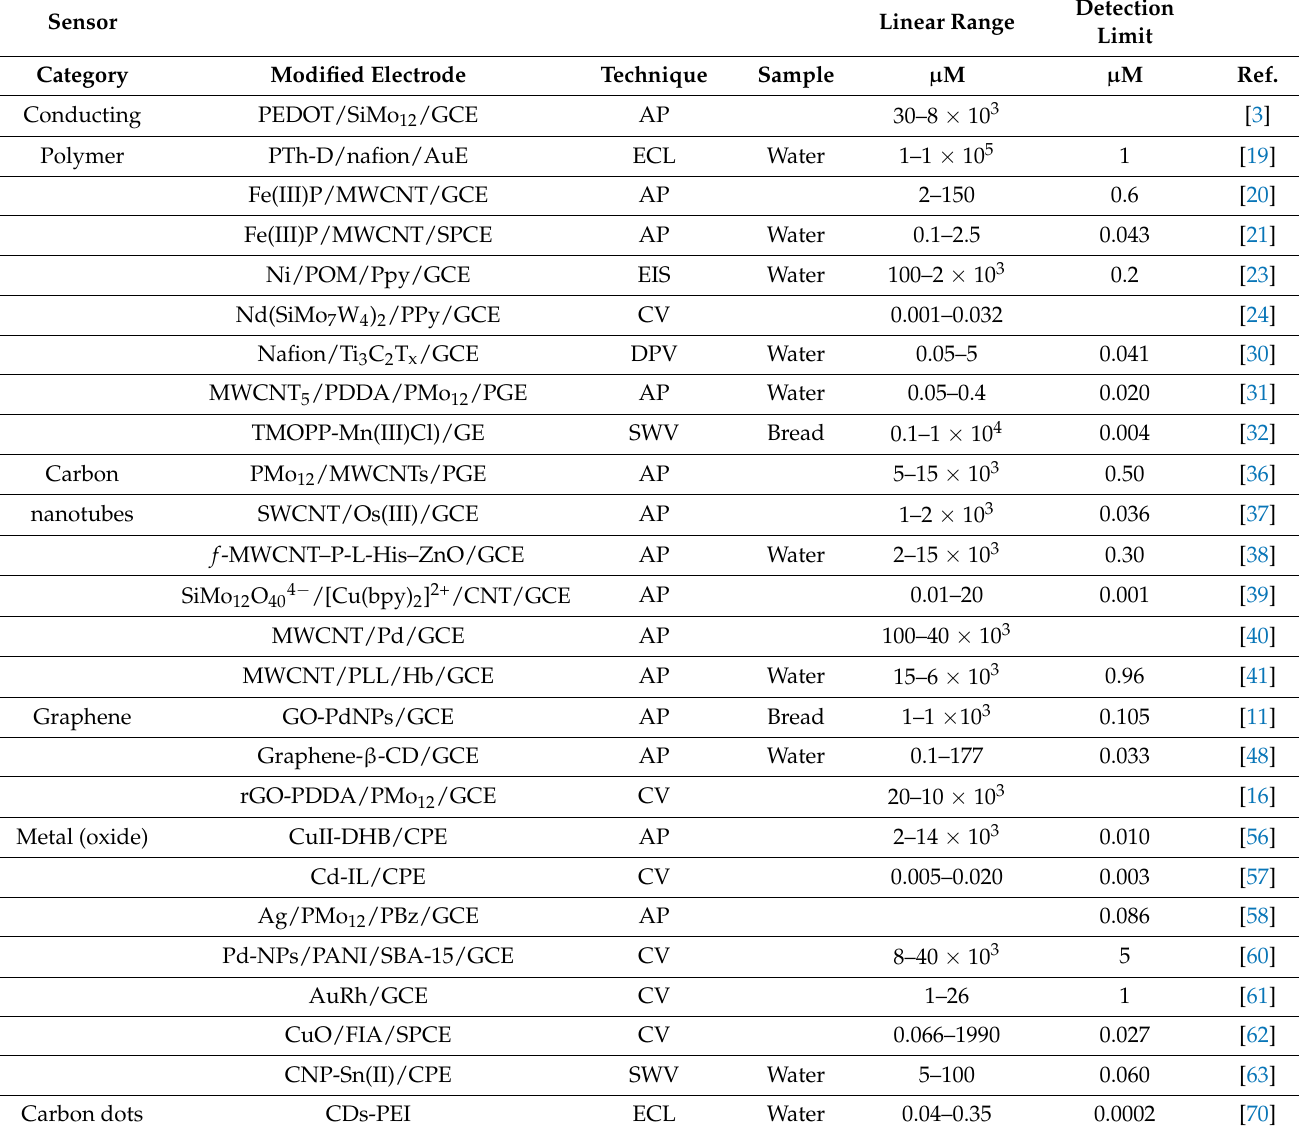
Table 2. Different electrochemical methods and sensors for bromate